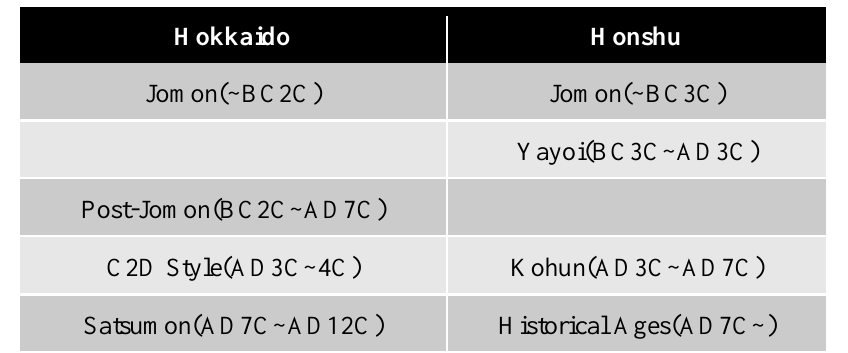
Table 2. Table of chronology, Hokkaido and Honshu (rest of Japan).